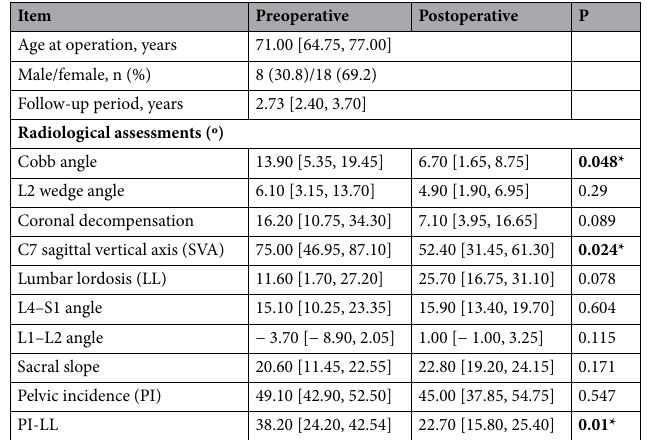
Table 1. Demographic data and differences between pre- and postoperative (after 2nd surgery) radiological parameters. Data are shown as median [interquartile range]. *Significant difference for before vs. after surgery.